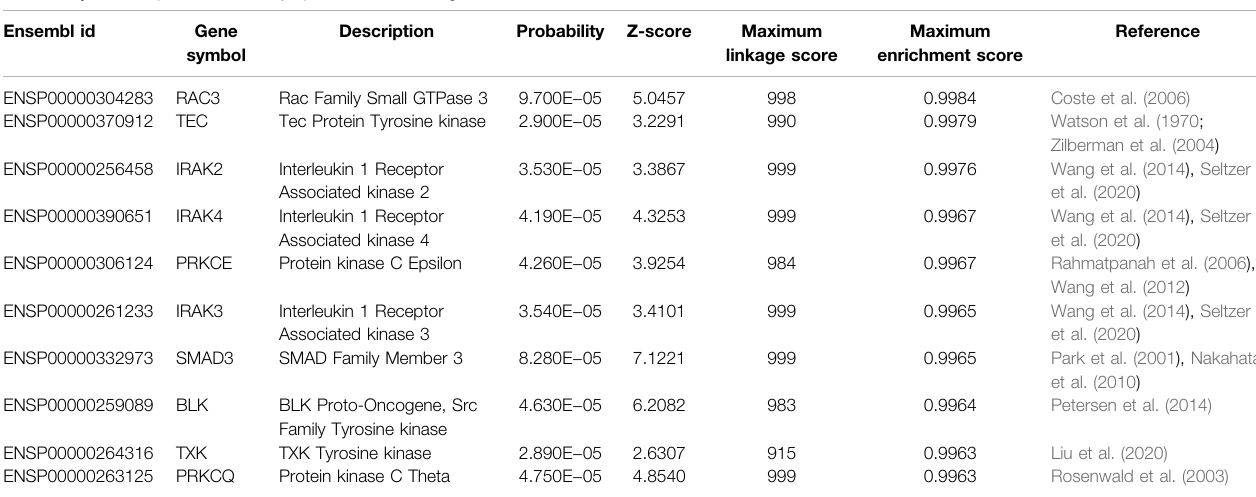
TABLE 1 | Some important inferred lymphoma-associated